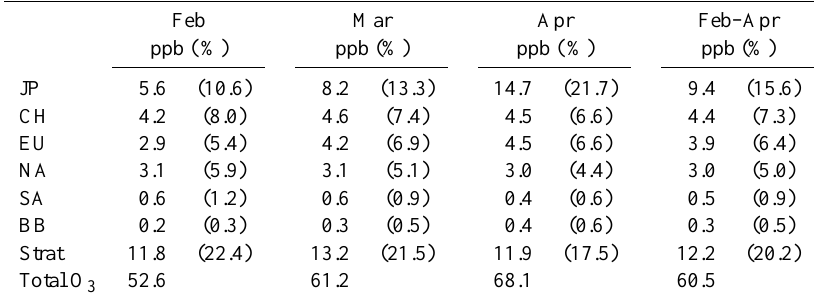
Table 5. Source Contributions to Afternoon Surface O 3 in Tokyo During Spring 2001.